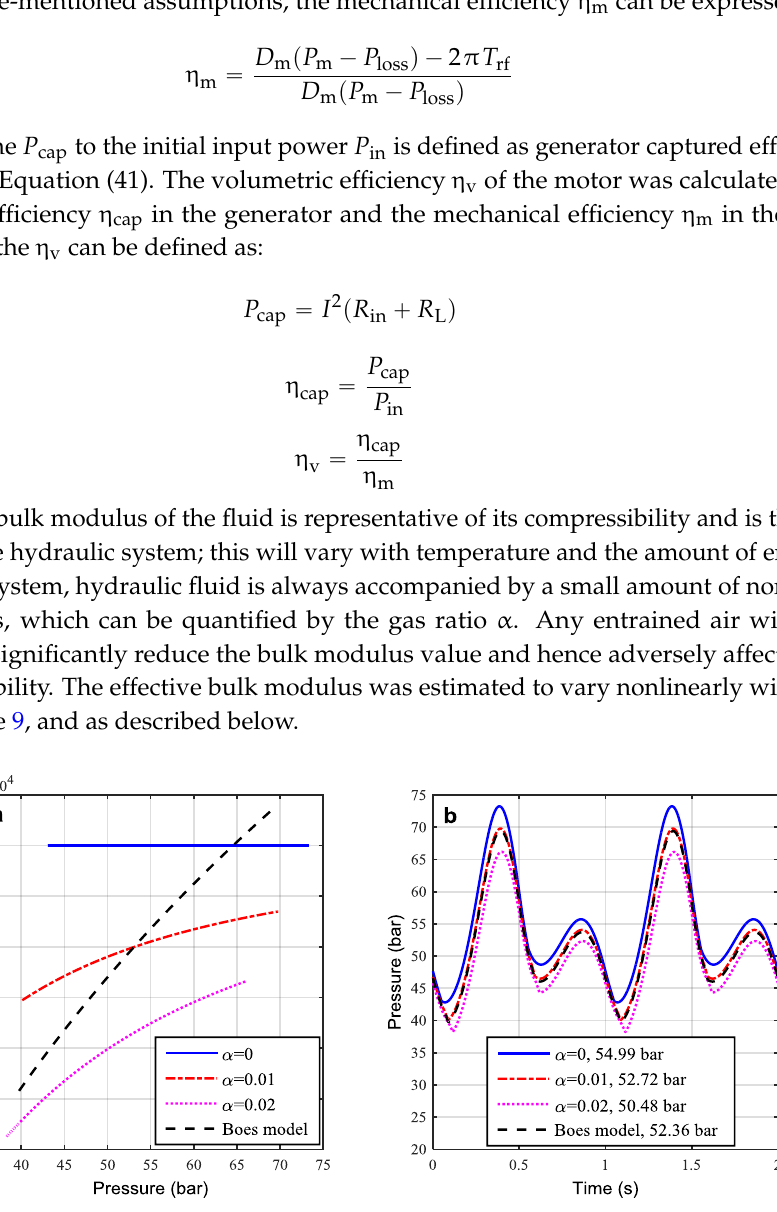
Figure 9. ( a ) Bulk modulus variation with motor pressure; ( b ) predicted motor pressures for different bulk modulus values.